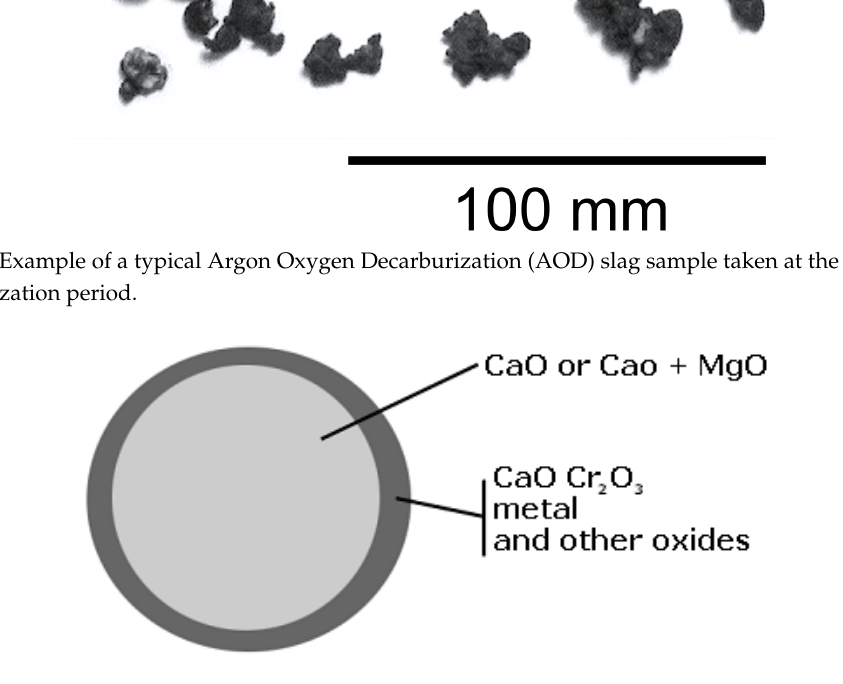
Figure 3. Schematic overview of a typical particle in a slag sample taken at the end of the decarburization period (Figure